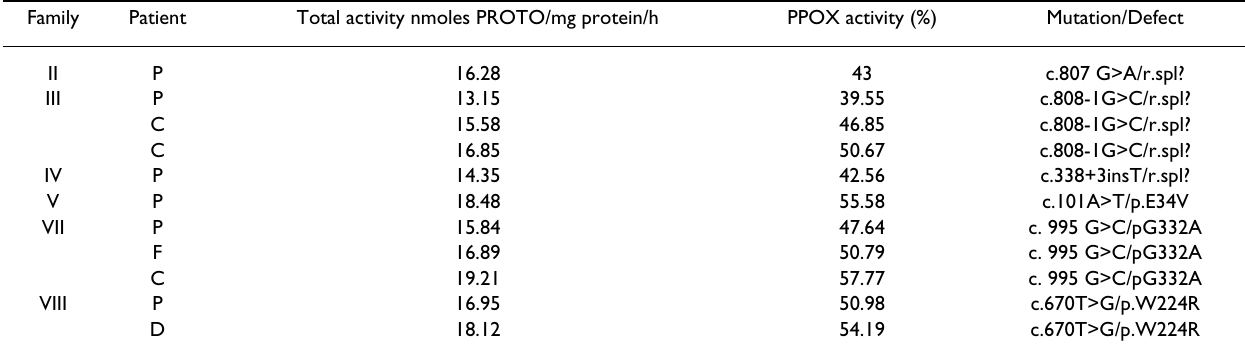
Table 3: Protoporphyrinogen oxidase activity